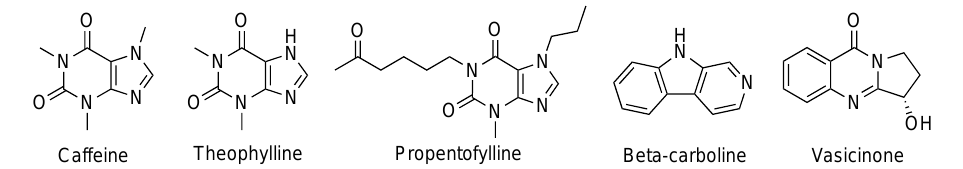
Figure 2. Chemical structures of representative alkaloids and derivatives considered in the cited studies: caffeine, theophylline, propentofylline, beta-carboline and vascinone.